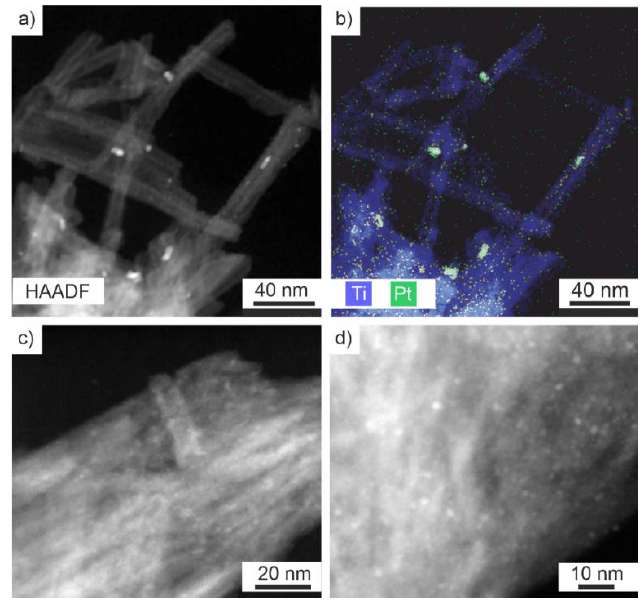
Figure 4. TEM analysis of Pt/TNTs: ( a ) HAADF-STEM image of long Pt/TNTs with ( b ) EDXS element map. ( c ) HAADF-STEM image of short Pt/TNTs with ( d ) HRTEM image.